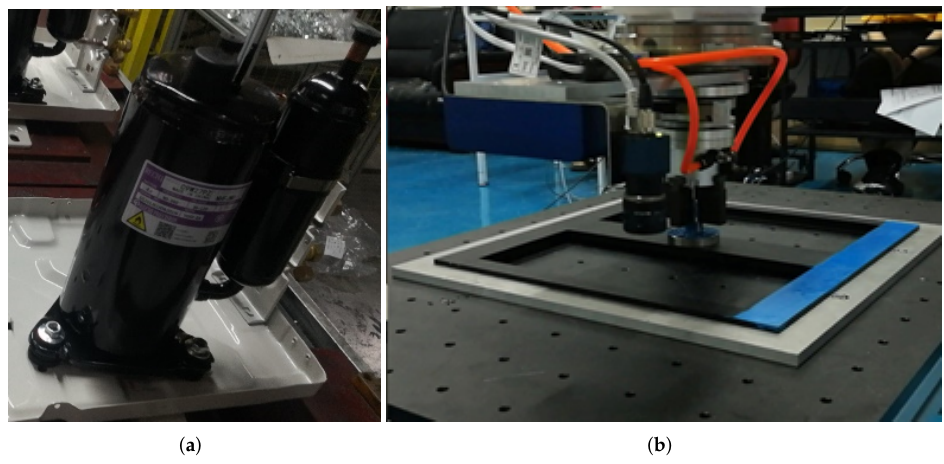
Figure 1. Two examples of robot-based assembly. ( a ) An air compressor assembly. ( b ) A rectangular workpiece